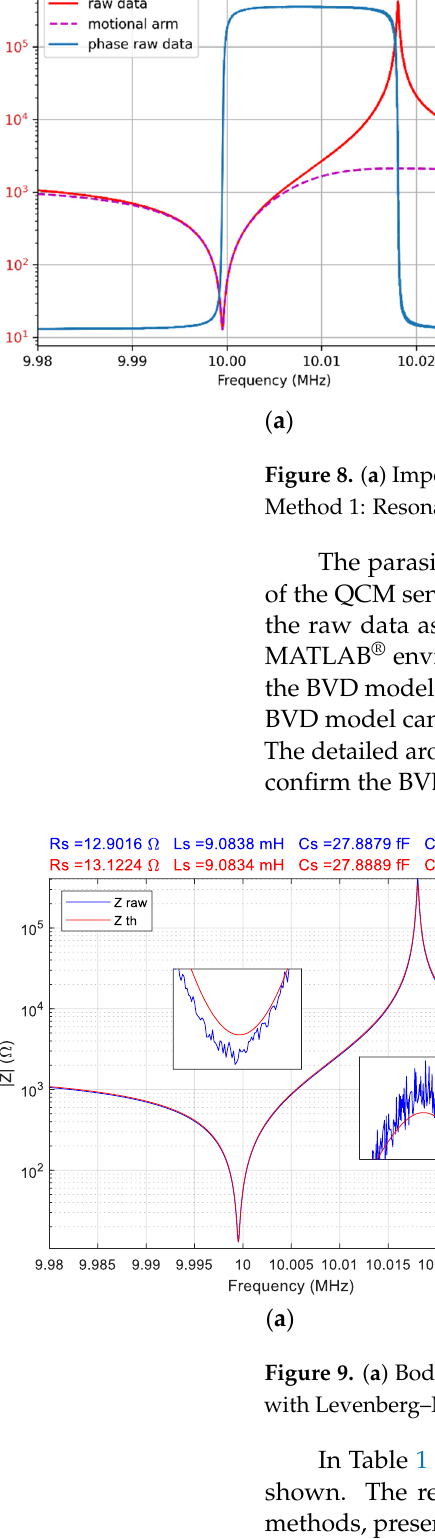
Table 1. BVD model parameters for QCM sensor depending on the computation method.